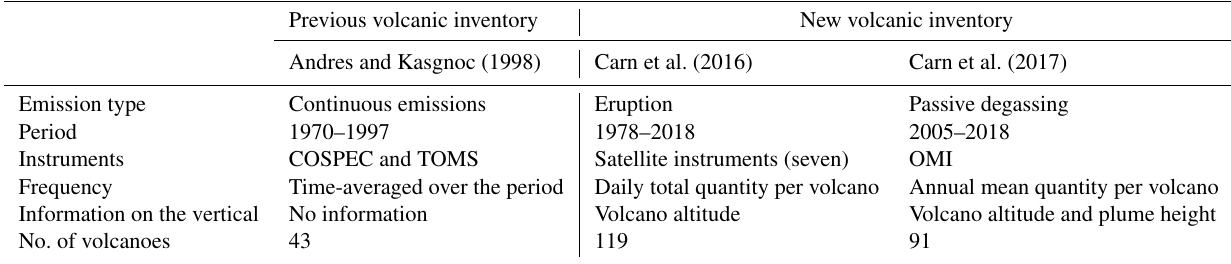
Table 1. Summary of the main characteristics of the previous (Andres and Kasgnoc, 1998) and the updated (Carn et al., 2016, 2017) SO 2 volcanic emission inventories.